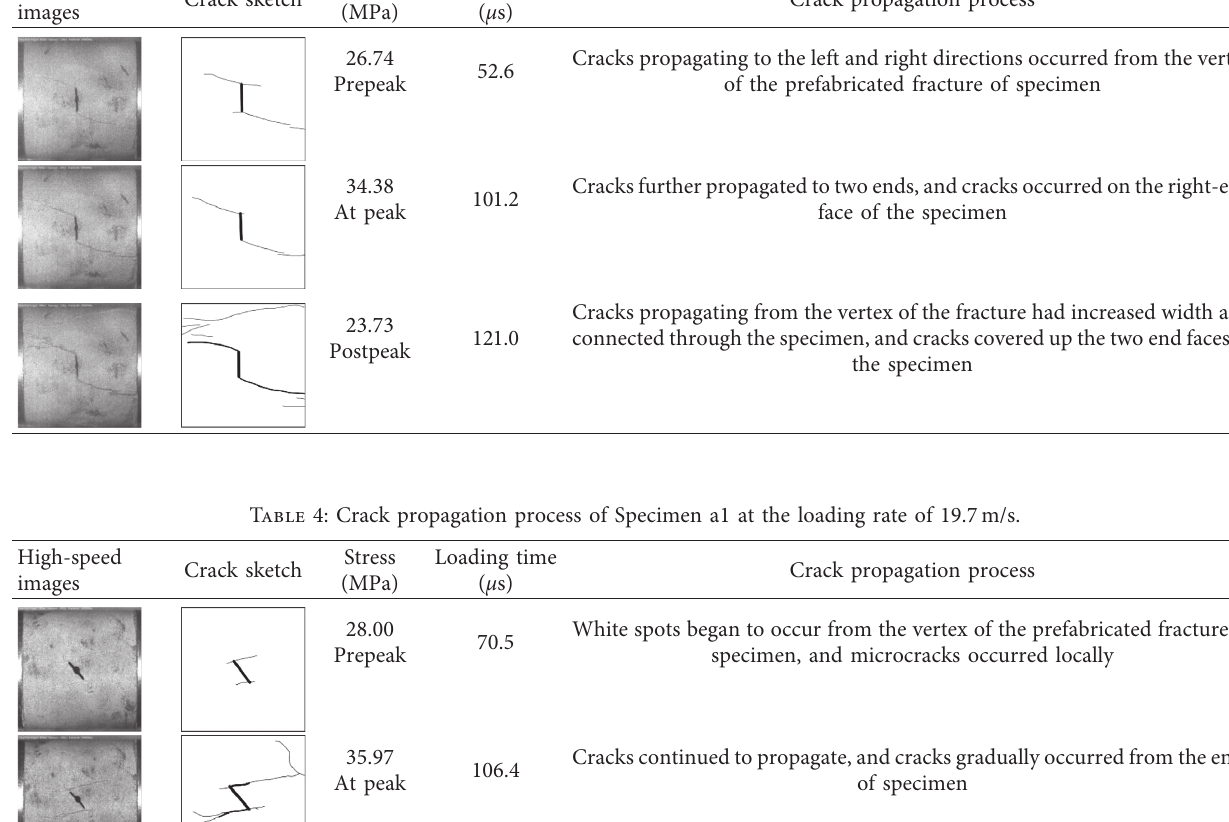
Table 3: Crack propagation process of Specimen c3 at the loading rate of 11.4m/s. High-speed images